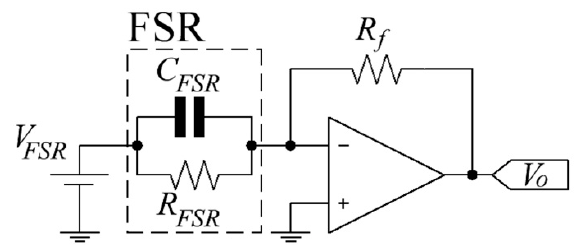
Figure 5. The manufacturer’s recommended method for measuring the sensor’s resistance ( R FSR ) based on an amplifier in an inverting configuration [11].